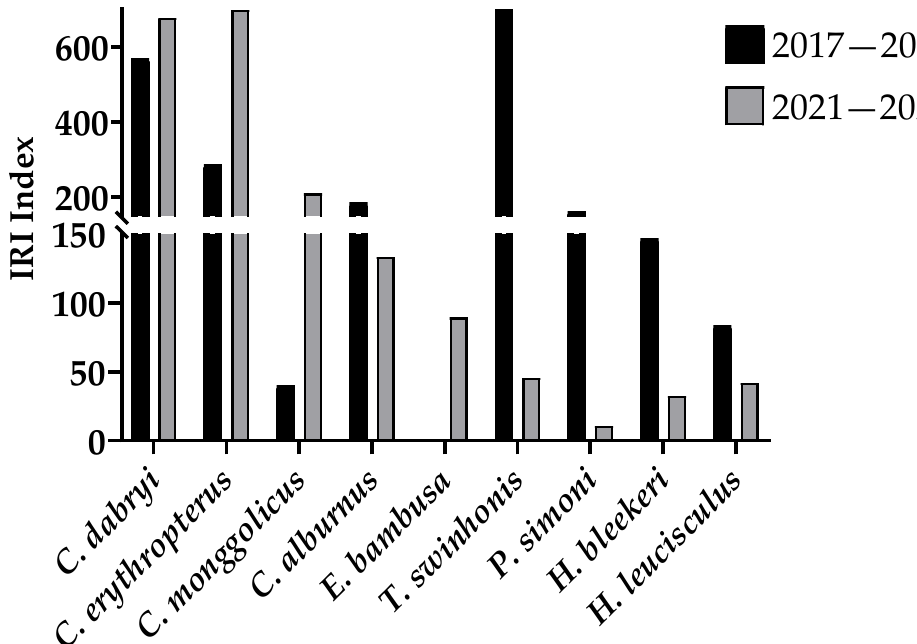
Figure 5. The IRI of carnivorous fish and small omnivorous fish in the seine area of the southern part of Gehu Lake in 2017–2018 and 2021–2022.